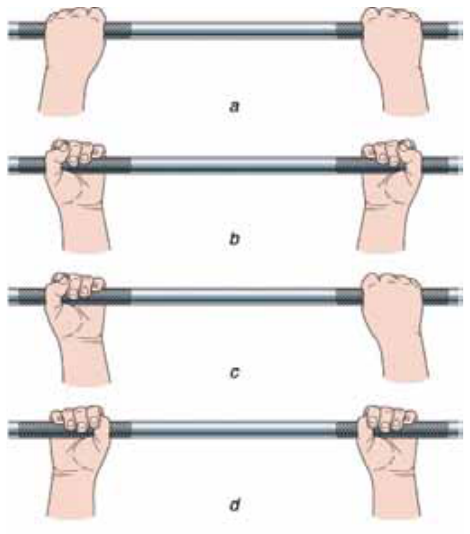
Figure 3-1. Examples of Different Barbell Grips: a) Pronated/ Overhand, b) Supinated/Underhand, c) Alternated, and d) Hook